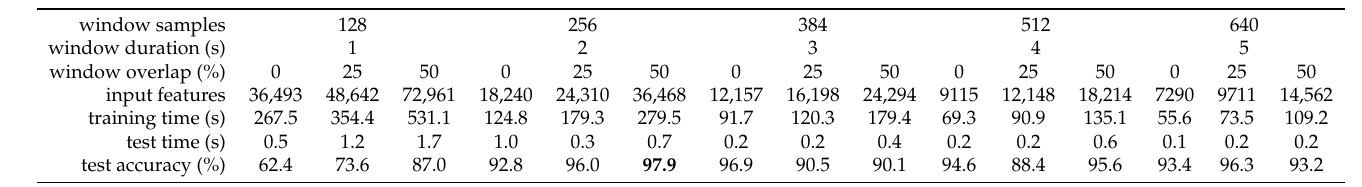
Table 5. Experimental results for PCA data using 50 principal components, best result is displayed in bold.